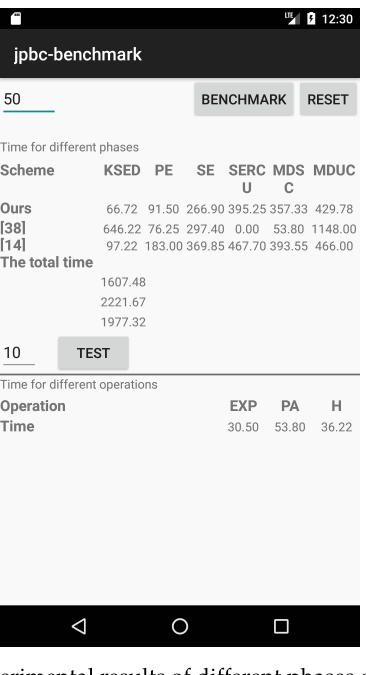
Figure 6. The experimental results of different phases on mobile